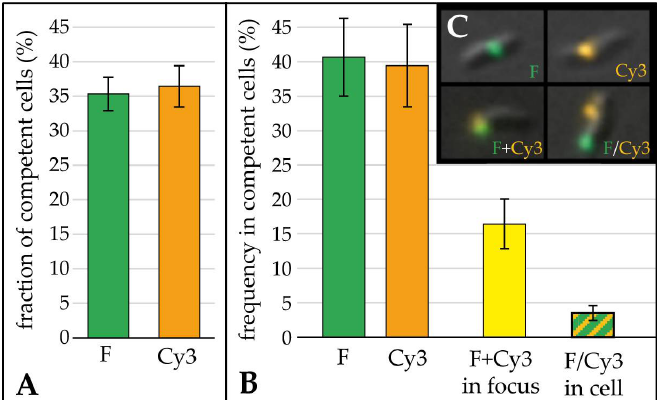
Figure 1. Visualization of import of multiple DNA molecules within one DNA uptake location. Fluorescein (F) and Cy3 labelled DNA was either added for 30 min to separate C. jejuni 81–176 suspensions (( A ), n ≥ 5) or in parallel to one bacterial competent culture (( B , C ), n = 4) and the fraction of cells with F and/or Cy3 fluorescent foci were analyzed. In ( A ) the fraction of active cells relative to the total number of bacteria is shown, in ( B ) the fraction of cells with fluorescent foci relative to the overall fraction of competent cells is depicted. Green bars, cells with only fluorescein labelled DNA foci; orange bars, cells with only Cy3 labelled DNA foci; yellow bar, cells with both fluorescein and Cy3 DNA in one/or two single focus/foci; green/orange hatched bar, cells with at least two separate foci, with either fluorescein or Cy3 DNA. ( C ), overlay image of differential phase contrast (DIC), Cy3 and F channel. Green, fluorescein focus; orange, Cy3 focus.